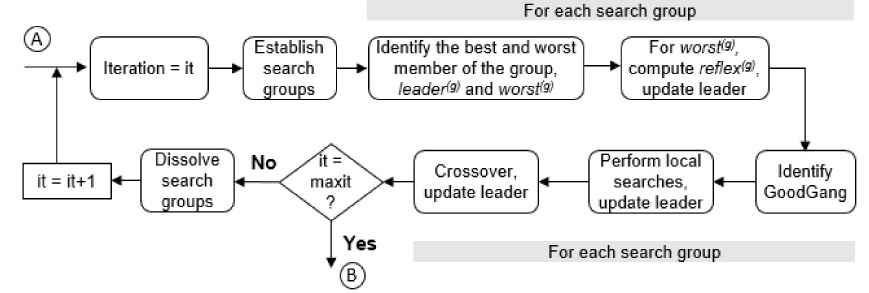
Figure 8. The flowchart of a SWA